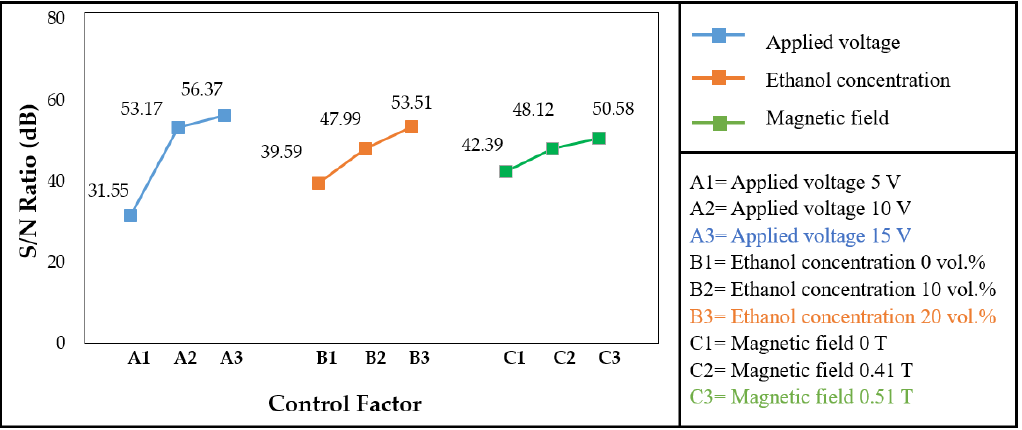
Figure 3. Plot of control factor effect.